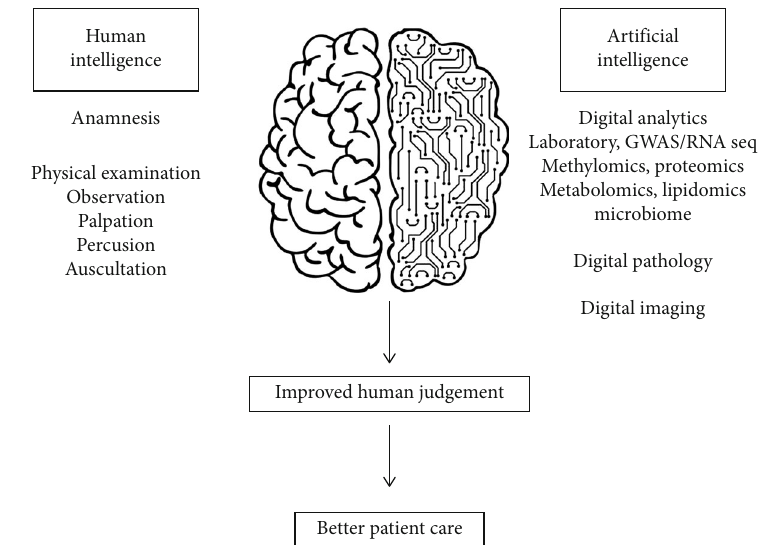
Figure 2: A new collective intelligence for a smarter patient care. Arti fi cial intelligence should be viewed as a complementary tool for the physician. With the help of arti fi cial intelligence systems, oncologists will be able to combine its clinical knowledge with massive amounts of data. As a consequence, oncologists will be able to discern new relevant patterns and will gather insights in a way that human intelligence alone cannot do, ultimately improving diagnosis and